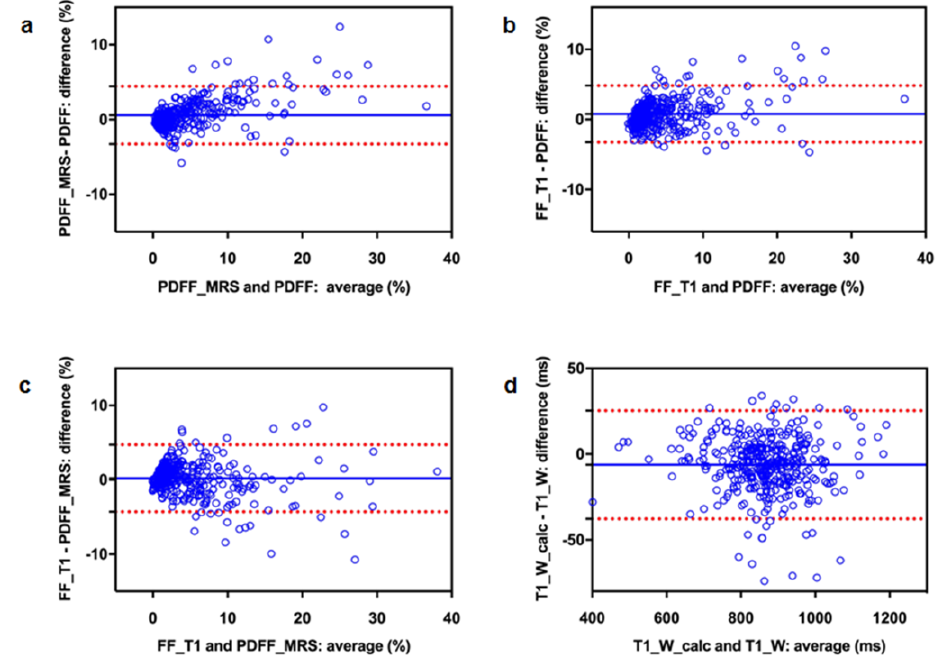
Figure 4. Bland – Altman plots to compare three different methods for fat quantification ( a – c ) as well as measured and retrospectively calculated T1_W (d): ( a ) PDFF_MRS vs. PDFF, ( b ) FF_T1 vs. PDFF, ( c ) FF_T1 vs. PDFF_MRS and ( d ) T1_W_calc vs. T1_W. The blue line represents the mean difference, the red dotted lines indicate the 95% confidence interval.